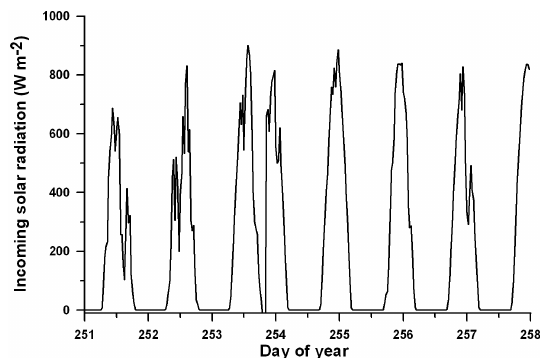
Fig. 3. Number of AmeriFlux sites with data for each year from 1991 to 2011 based on the CDIAC AmeriFlux data collection in January 2013.